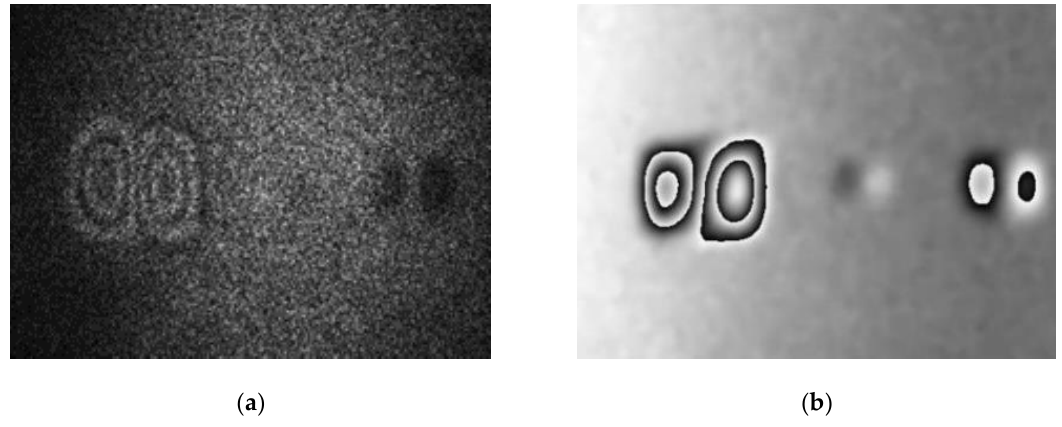
Figure 4. Comparison between ( a ) real-time subtraction version and ( b ) phase-shift shearography.